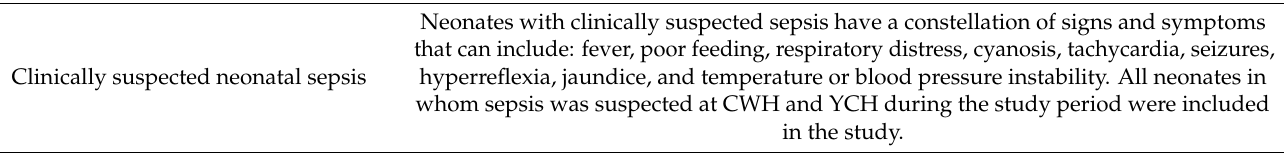
Table 1. Operational definitions of types of sepsis and other operational definitions utilized in Yangon, Myanmar, January 2017–December 2019. Neonatal